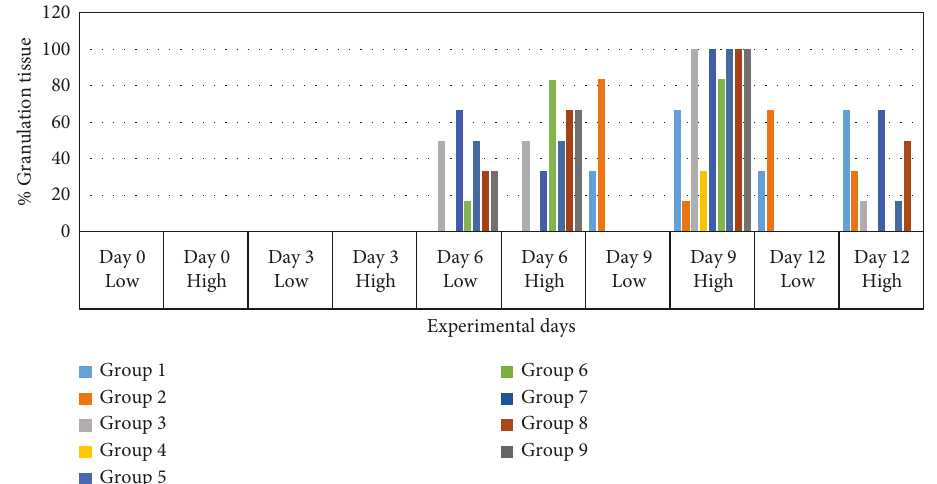
Figure 8: Wound granulation tissue (%) in experimental groups on days 3, 6 and 9, and 12 after